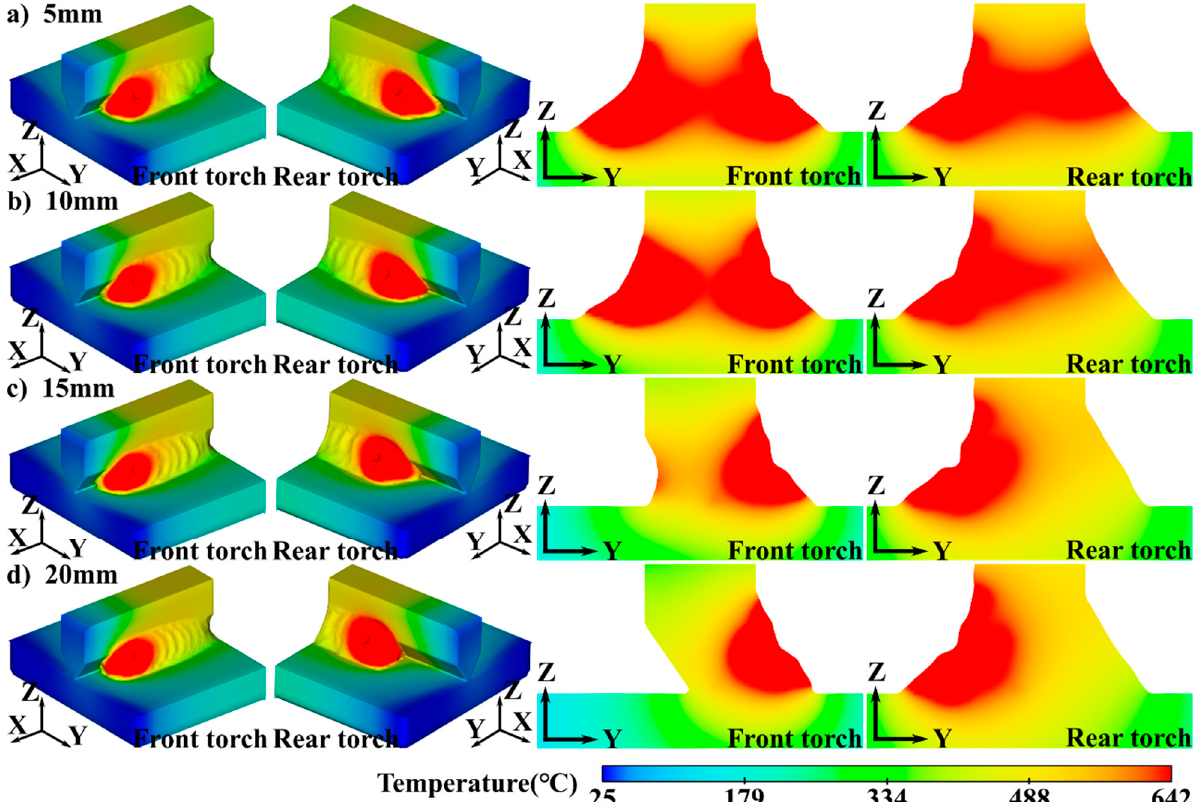
Figure 11. Temperature distribution on the model surface (the first and second column) and cross-section (the third and fourth column) at the welding time of 7.0 s: torch distances of ( a ) 5 mm, ( b ) 10 mm, ( c ) 15 mm, and ( d ) 20 mm.